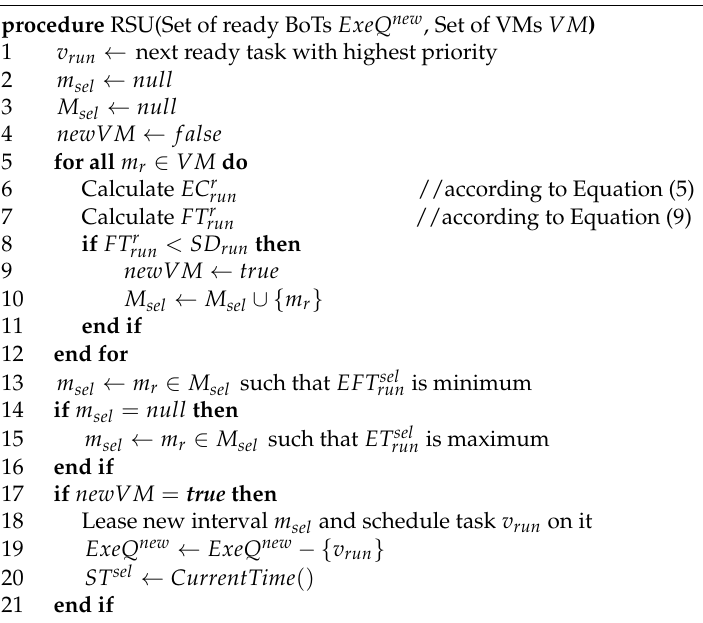
Algorithm 4 Resource Scaling Up